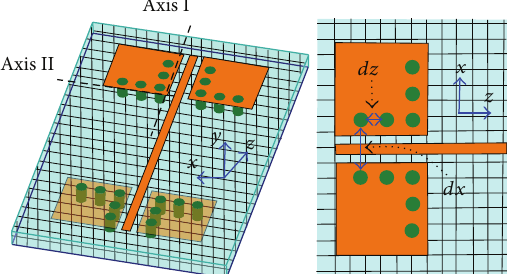
Figure 3: GCPW-MS-GCPW transition with optimized via-holes: 𝑑𝑥 = 𝑑𝑧 = 250 𝜇 m, the via-hole near the corner of the coplanar pads is located 200 𝜇 m from both axes I and II, and via-hole diameter has 3 different values: 50, 75, and 100 𝜇 m (not to